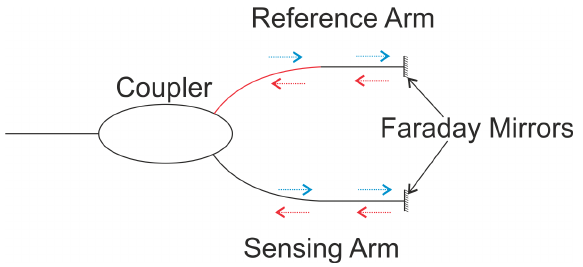
Figure 6. Principle of MI (based on reference